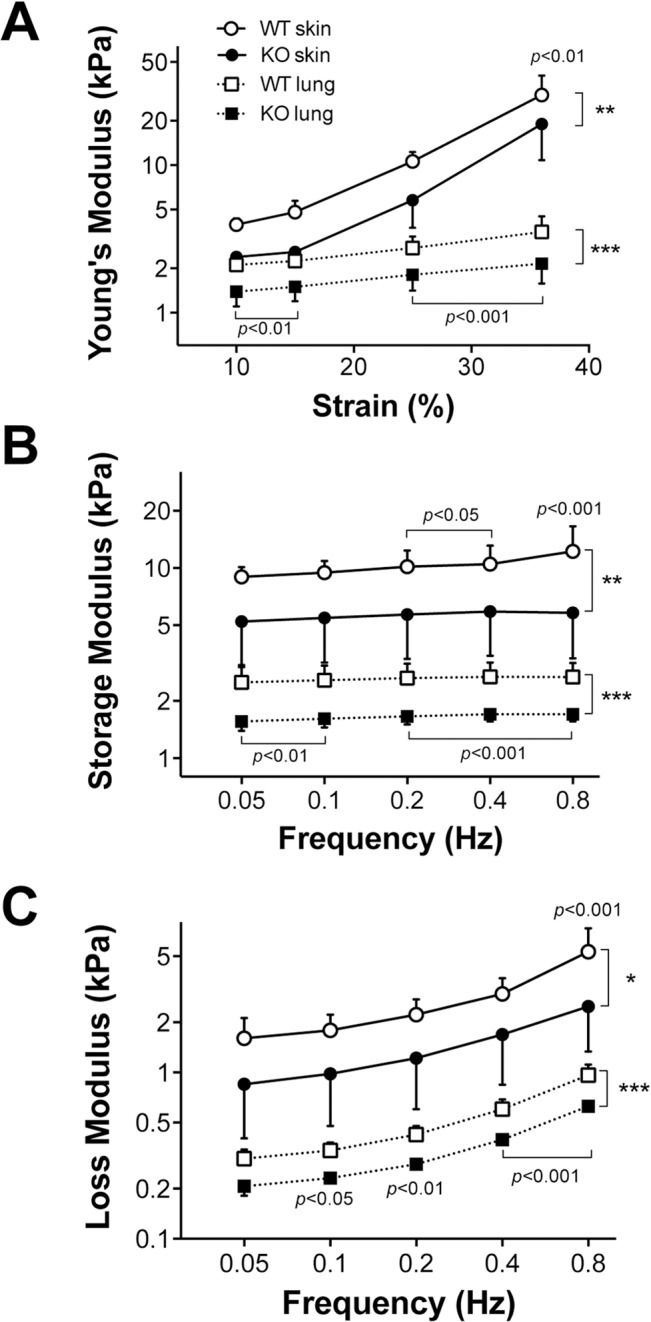
Mouse KO skin and lung are less stiff than WT skin and lung.A 3x1x1 mm strip of dorsal skin or lung tissue was placed longitudinally into a computer-controlled dual-mode lever arm force transducer system and stretched intermittently. A. Young’s module plotted at each strain. The Young’s module is the slope of the stress-strain curve. B. Dynamic stretch storage modulus describes the ability of the material to store elastic energy during the loading phase of a cyclic stretch C. Dynamic stretch loss modulus—The amount of energy lost (usually as heat) during a cycle. Vertical brackets denote the overall group differences using 2-way repeated measure ANOVA (*: p<0.05, **: p<0.01 and ***: p<0.001) whereas horizontal brackets show Tukey’s post hoc differences between WT and KO at the same strain (Panel A) or frequency (Panels B and C). For the Young’s and loss moduli of lung tissue, there are also significant interactions between strain and group (panel A) as well as frequency and group (panel C, p<0.05). For the skin, there is a significant interaction between frequency and group only for the loss modulus (p<0.05).